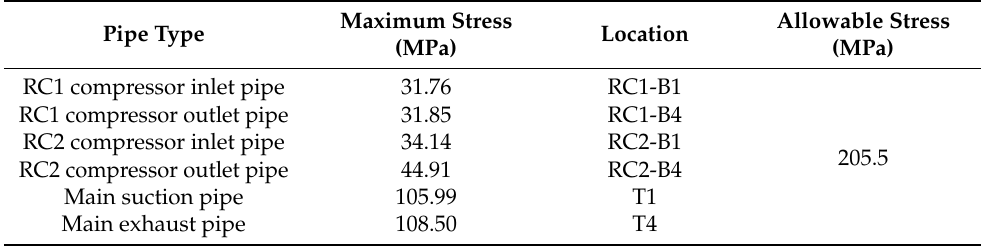
Table 4. Summary of maximum stress and